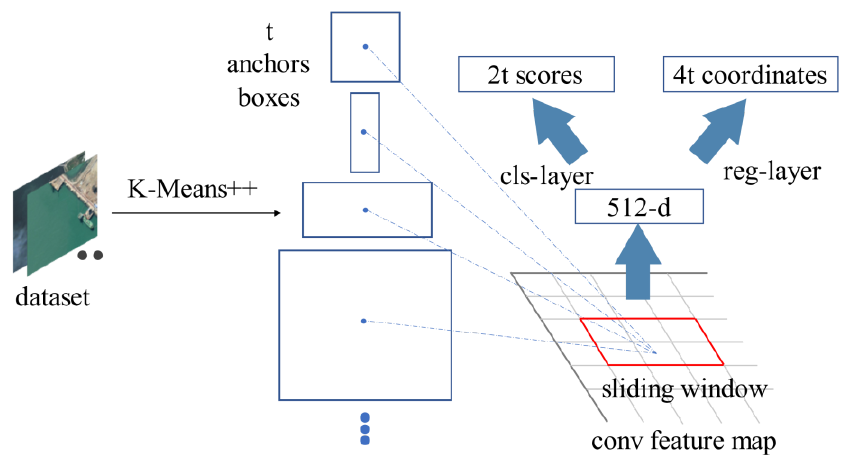
Figure 5. The structure of K-RPN in proposed model.